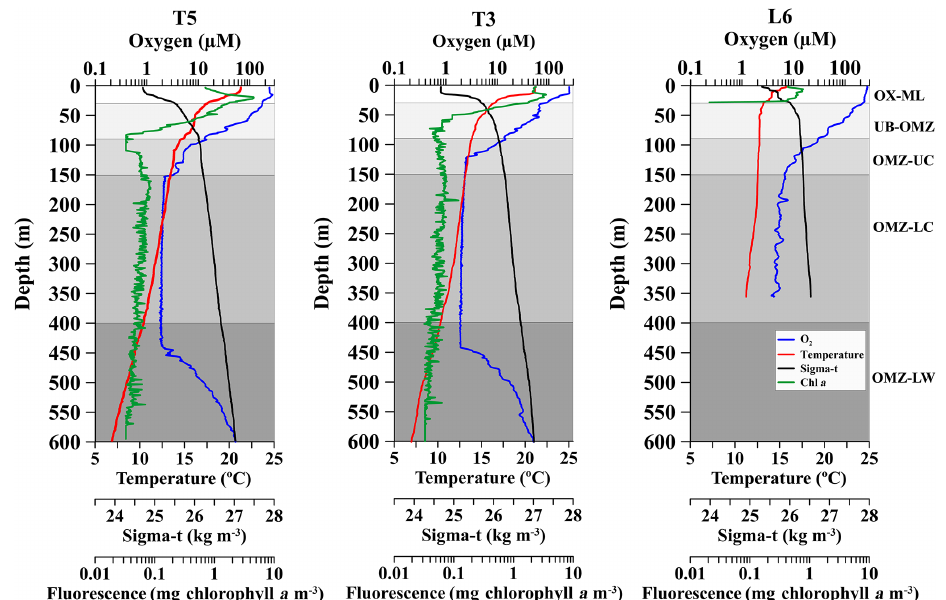
Figure 2. Vertical profiles of dissolved oxygen (O 2 ), temperature, chlorophyll a and water density ( σt ), at three stations off northern Chile (see Fig. 1) during the Lowphox Cruise in the austral spring 2015. Shaded areas represent different layers sampled with the MultiNet and defined according to oxygen concentration. OX-M is the oxic mixed layer, OMZ-UB is the upper boundary of the oxygen minimum zone, OMZ-UC is the upper core of the oxygen minimum zone, OMZ-LC is the lower core of the OMZ and OMZ-LW is the lower oxygen